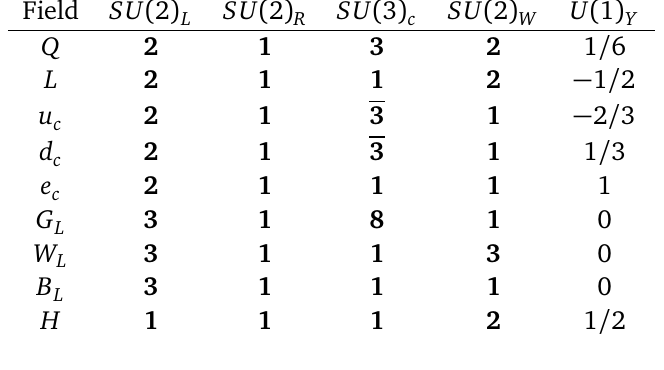
Table 1: The field content of the SMEFT wiith representations under the Lorentz × SU ( 2 ) group SU ( 2 ) , and the gauge group SU ( 3 ) L R